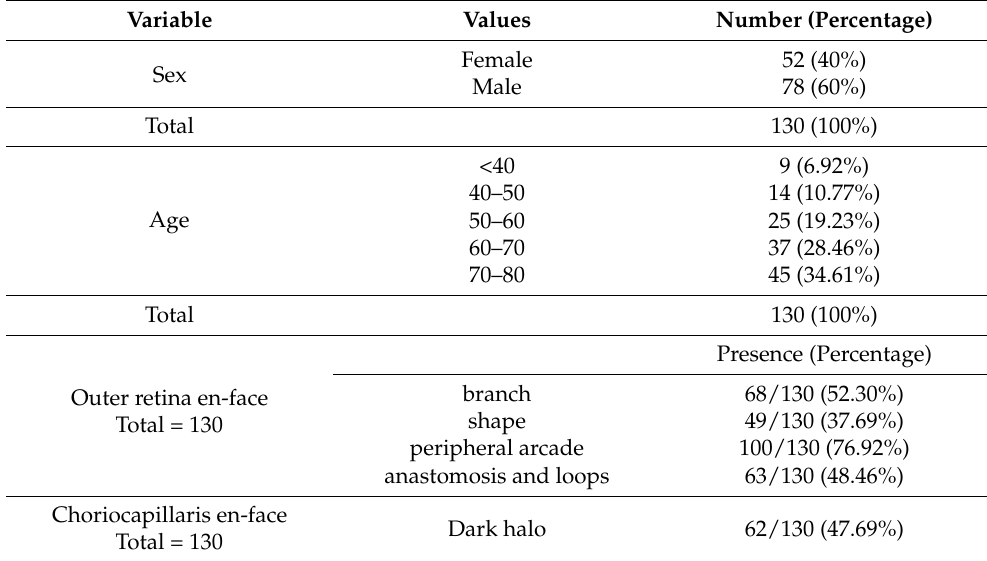
Table 1. Demographic characteristics of the patients in the